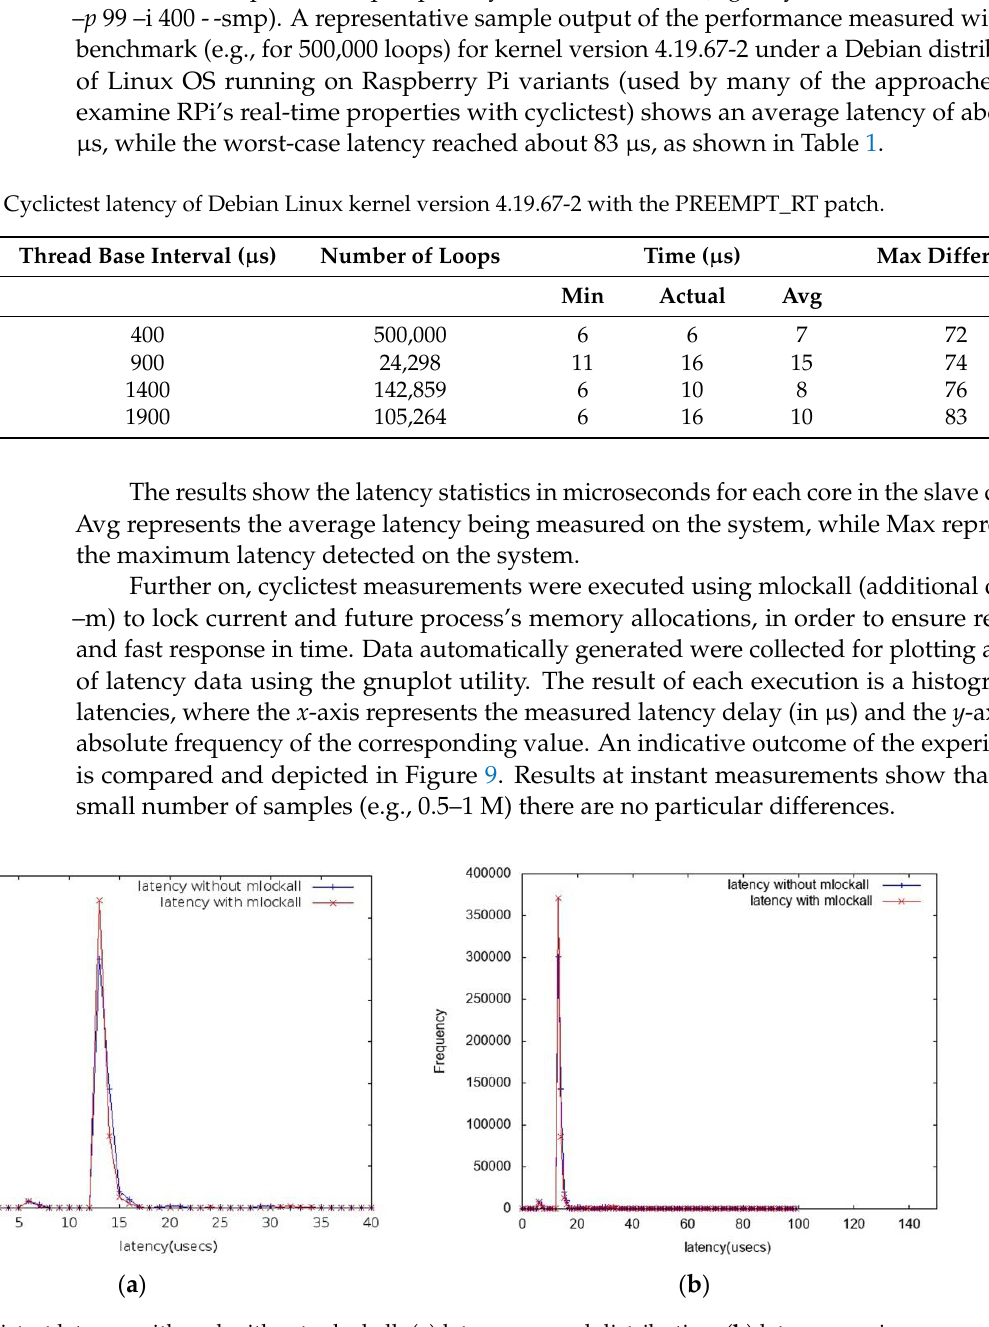
Figure 9. Cyclictest latency with and without mlockall: ( a ) latency normal distribution; ( b ) latency maximum. Table 1. Cyclictest latency of Debian Linux kernel version 4.19.67-2 with the PREEMPT_RT patch.